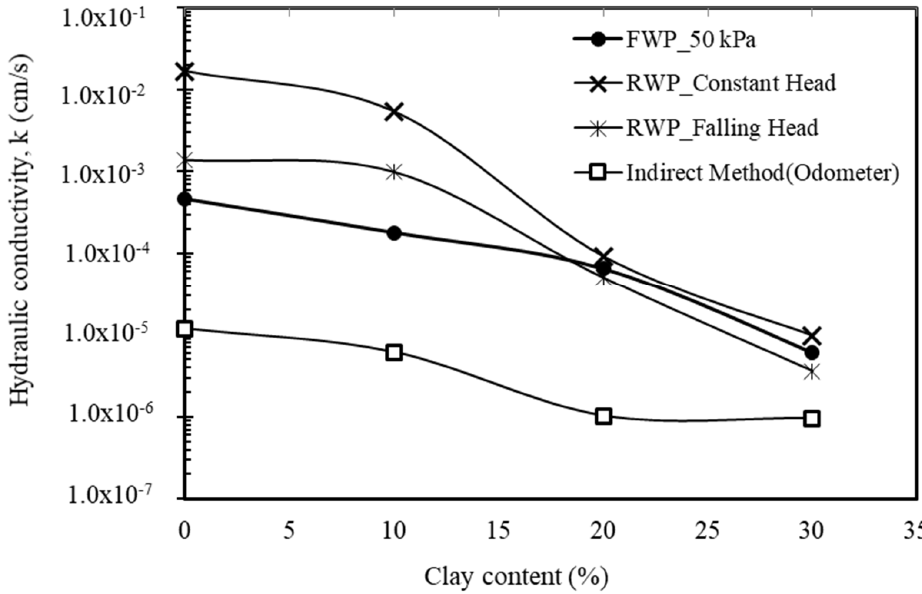
Figure 6. Hydraulic conductivity for a flexible wall at 50 kPa stress compared to other methods.